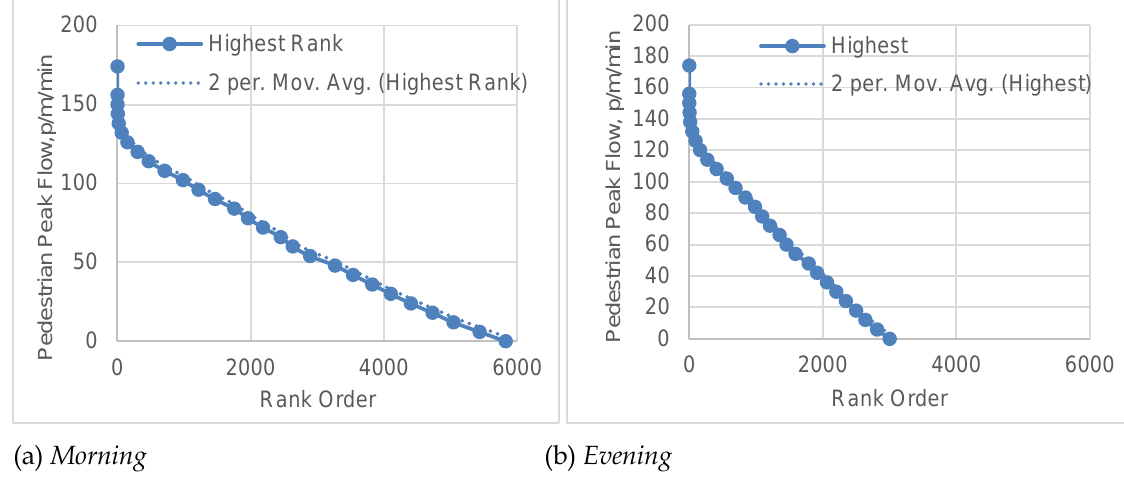
Figure 8. Peak Pedestrian Flows plotted as per their Rank Order The peak flows were found reaching a zero value at the highest rank order. This is logical for escalators at metro stations. Flows on escalators are controlled by the arrival and departure of the train, which runs with minimum headway of 3 mins or more. Other influencing factor is the location of the escalator at the platform. The flow on the nearest escalator builds very fast and subsides too. So, there will be periods when there will not be any flow on the escalator. These instances will increase if headway is high, or the extraction interval is low. The plots presented in the Figure 8 shows both the actual data plot and a moving-average trend line which follows the plot. The examination of the plots indicates that the 98 th percentile peak flow in both the time periods is rank ordered as 5. Therefore, 5 th highest rank ordered value of the peak flows can be used for the design purpose. This is reasonably lower than the highest peak flow observed which is more than 170